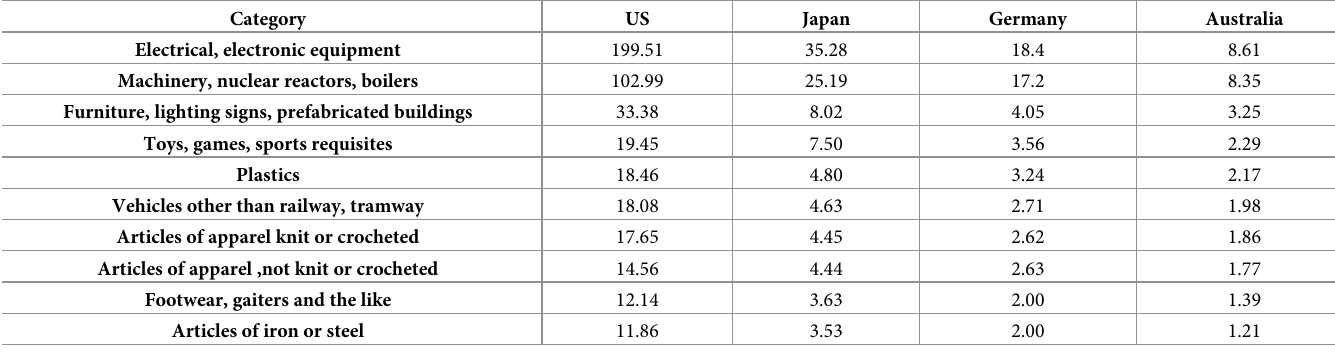
Table 2. China exports (2018) in US billion